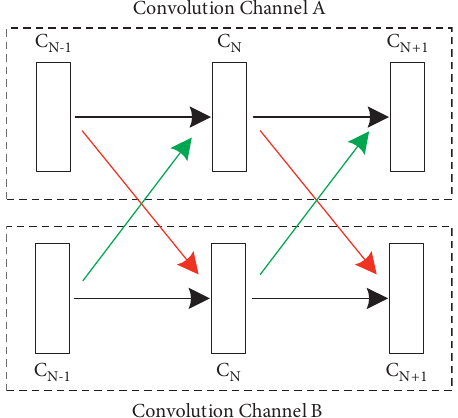
Figure 1: Structure diagram of cooperative